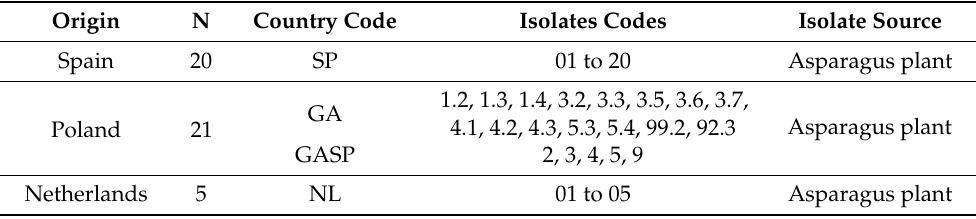
Table 1. Origin of Fusarium oxysporum isolates used in this study. Origin N Country